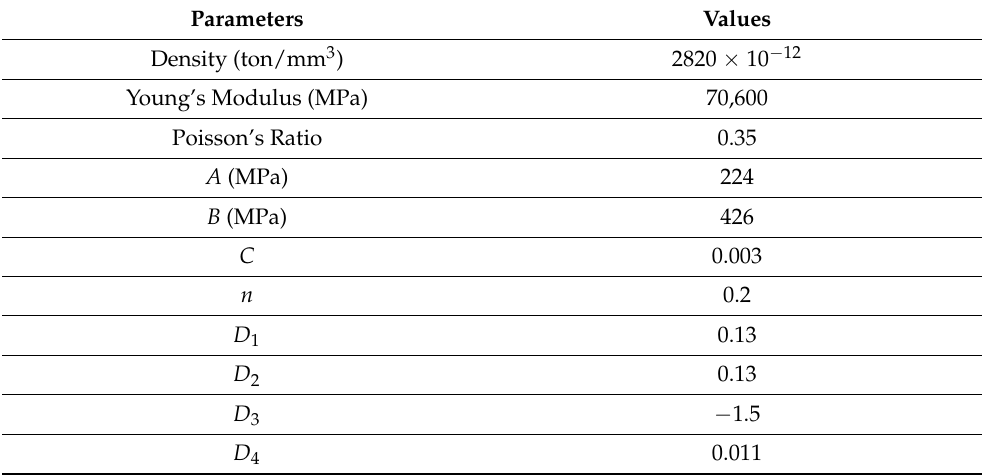
Table 2. Material properties and Johnson–Cook (JC) constants of the Al